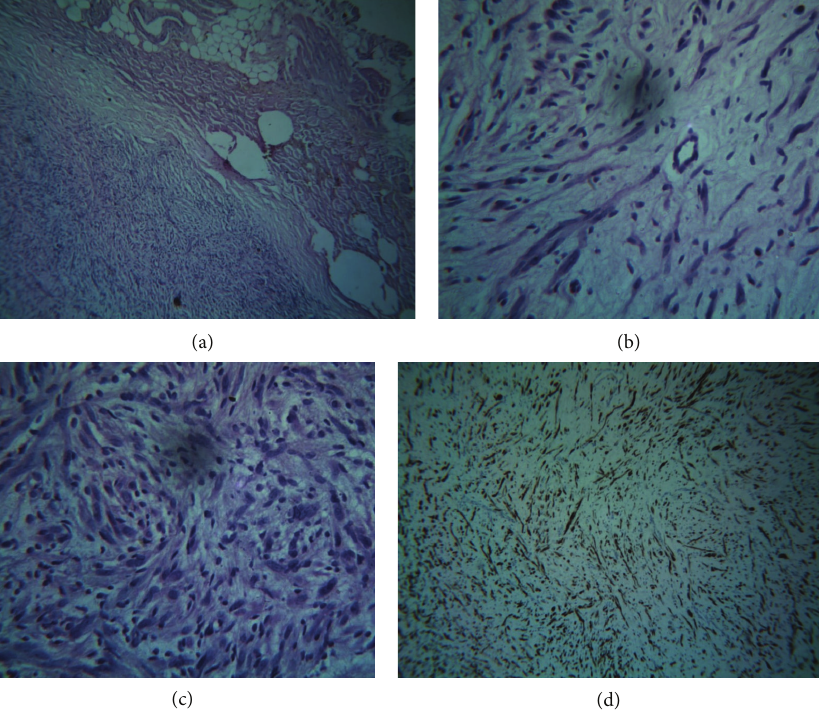
Figure 2: (a) Low power photomicrograph (H&E, 10x) showing fibrous capsule, surrounding the tumor mass. (b) High power photomicrograph (H&E, 40x) showing tumor mass consisting of fibrovascular, myxoid connective tissue stroma interspersed with elongated spindle shaped cells having wavy nuclei. (c) High power photomicrograph (H&E, 40x) showing multiple proliferating spindle shaped and round cells with pale round to oval nuclei. (d) High power photomicrograph (immunoperoxidase staining, 40x) showing strong immunoreactivity for